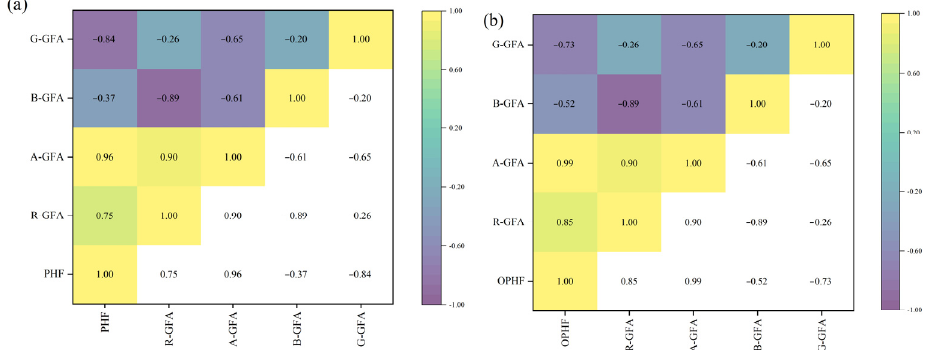
Figure 9. Correlations at mixed sites, ( a ) peak periods; ( b ) off-peak periods.